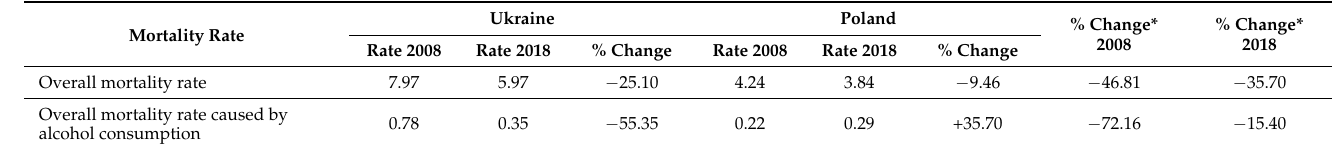
Table 5. Mortality working age